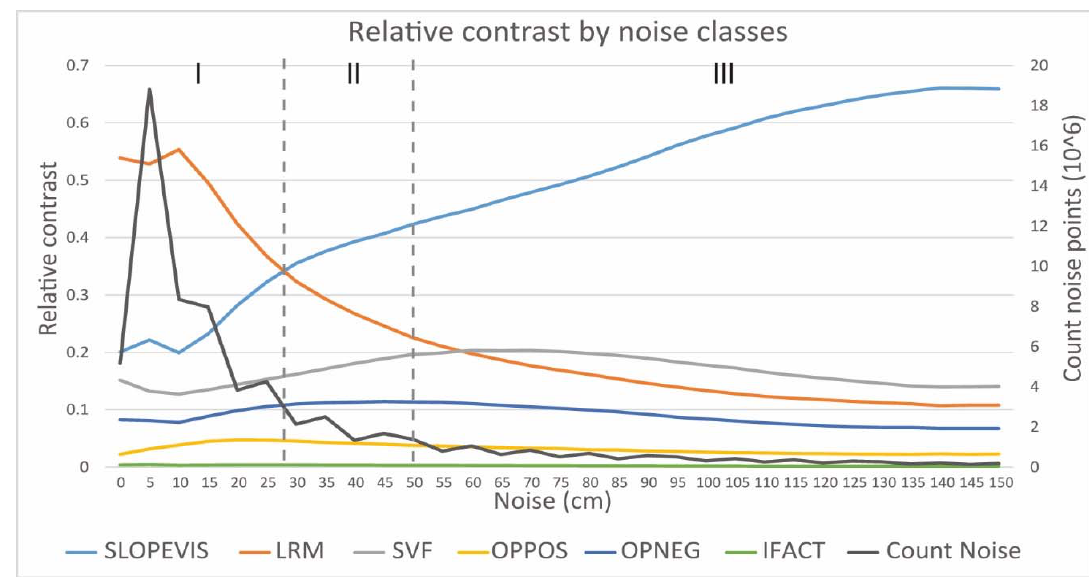
Figure 7. Relative contrast by noise classes and VTs.